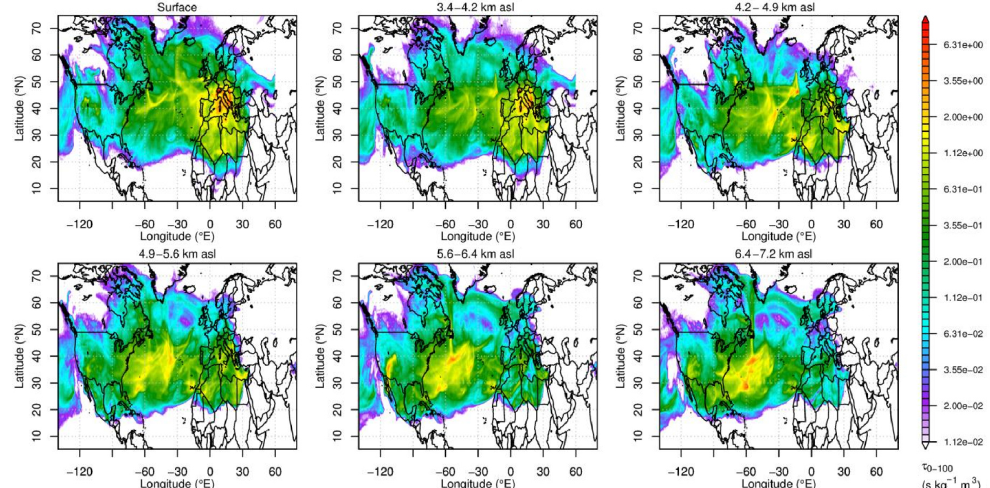
Figure 7. Surface source sensitivity (footprints) of the air masses at JFJ (surface in situ) and in the sub-columns above JFJ in January (CO 2 maximum of the FTIR data set) in the period 2009 to 2011 simulated with FLEXPART. The height of the sub-columns is given above the according subplots, the x axis is the longitude, the y axis represents the latitude, the color code of the sensitivity is given at the right side.